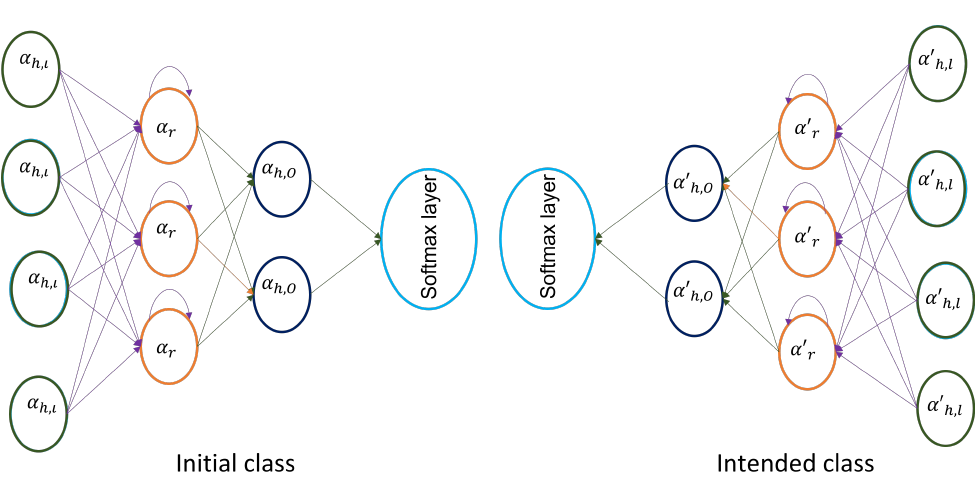
Figure 6. Diagram of transfer deep LSTM